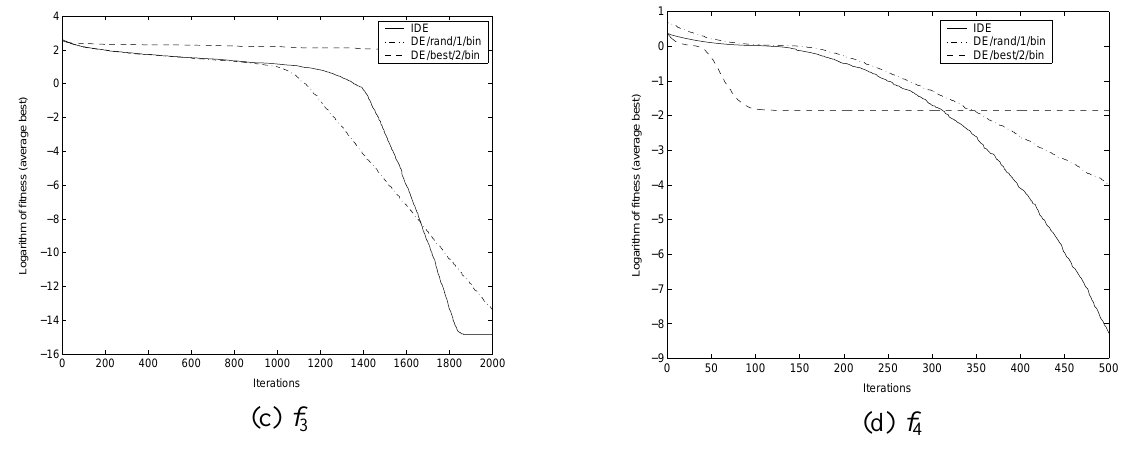
Fig. 1. Average best fitness curves of 50 runs for f 1 ∼ f 4